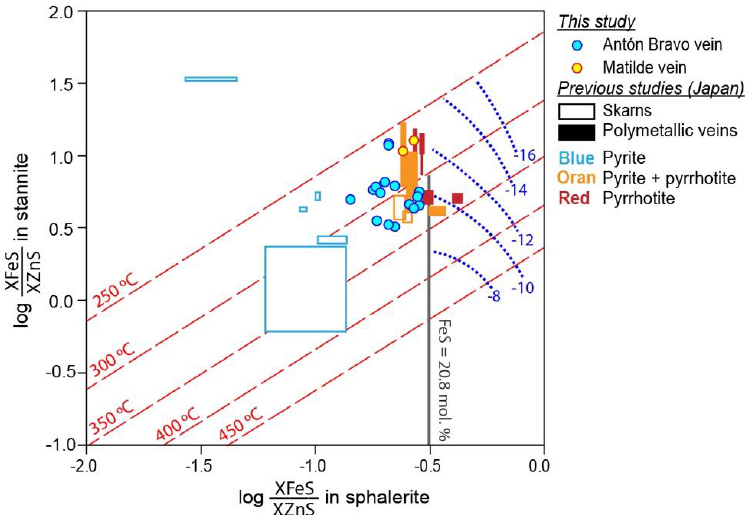
Figure 15. Binary log (XFeS / XZnS) sphalerite vs. log (XFeS / XZnS) stannite plot showing results for sphalerite and stannite from Huari Huari. Isotherms (dashed red lines) are based on data by Nakamura and Shima [61]. Blue dotted lines show log f (S 2 ) in the pyrrhotite stability field after Scott and Barnes [56]. The 20.8 mol. % FeS line in sphalerite corresponds to the composition of sphalerite in equilibrium with pyrrhotite at 1 bar [56]. Composition fields of coexisting stannite–sphalerite in Japanese deposits are shown for comparison [62,63].